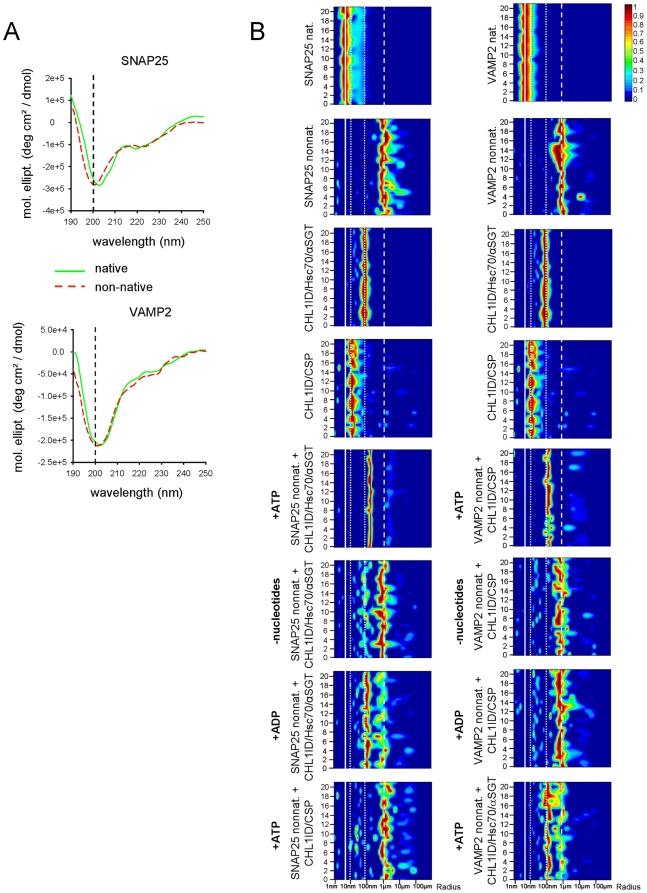
CHL1ID/Hsc70/αSGT and CHL1ID/CSP chaperone complexes dissolve aggregates of SNAP25 and VAMP2, respectively.
A – CD spectra of native and heat-treated non-native SNAP25 and VAMP2. Exposure of the proteins to 42°C for 10 min did not affect the secondary structure of the proteins, as revealed by almost identical CD spectra. A minor shift of the characteristic minimum towards 200 nm might indicate a slight increase in their random coil structure content. B - Distribution of the radii of the protein complexes as measured by DLS. Data from 22 consecutive DLS measurements are shown with signal intensities displayed in pseudocolor. Heat exposure results in aggregation of SNAP25 and VAMP2 (solid and dashed lines mark the size of particles formed by proteins in native and non-native conformations, respectively). CHL1ID, Hsc70 and αSGT form a complex, which is larger than the complex formed by CHL1ID and CSP. The sizes of these complexes are marked by dotted lines (the same data are shown in two columns for reference). Note, that SNAP25 and VAMP2 aggregates are dispersed in the presence of ATP by CHL1ID/Hsc70/αSGT and CHL1ID/CSP, respectively. Protein aggregates are not dispersed in the absence of nucleotides or in the presence of ADP. Under these conditions, the aggregates and CHL1ID/Hsc70/αSGT complex are seen as assemblies of two distinct sizes, with the smaller CHL1ID/CSP complex being obscured by the larger aggregates, because the scattering intensity is proportional to the particle radius in the power of 3 [52]. SNAP25 aggregates are not dispersed by CHL1ID/CSP, and VAMP2 aggregates are not dispersed by CHL1ID/Hsc70/αSGT.